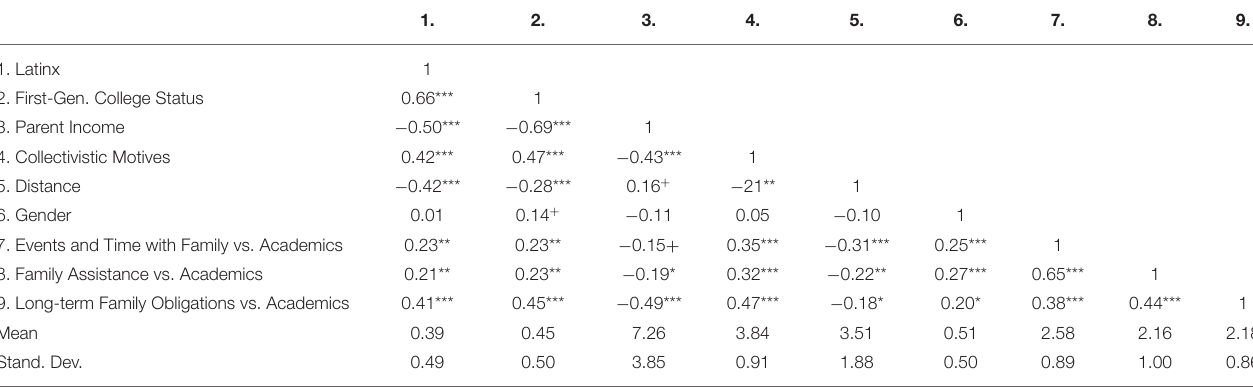
TABLE 1 | Zero-order Correlations for Variables of Interest in Models Assessing Antecedents of Home-School Cultural Value Mismatch. 1.